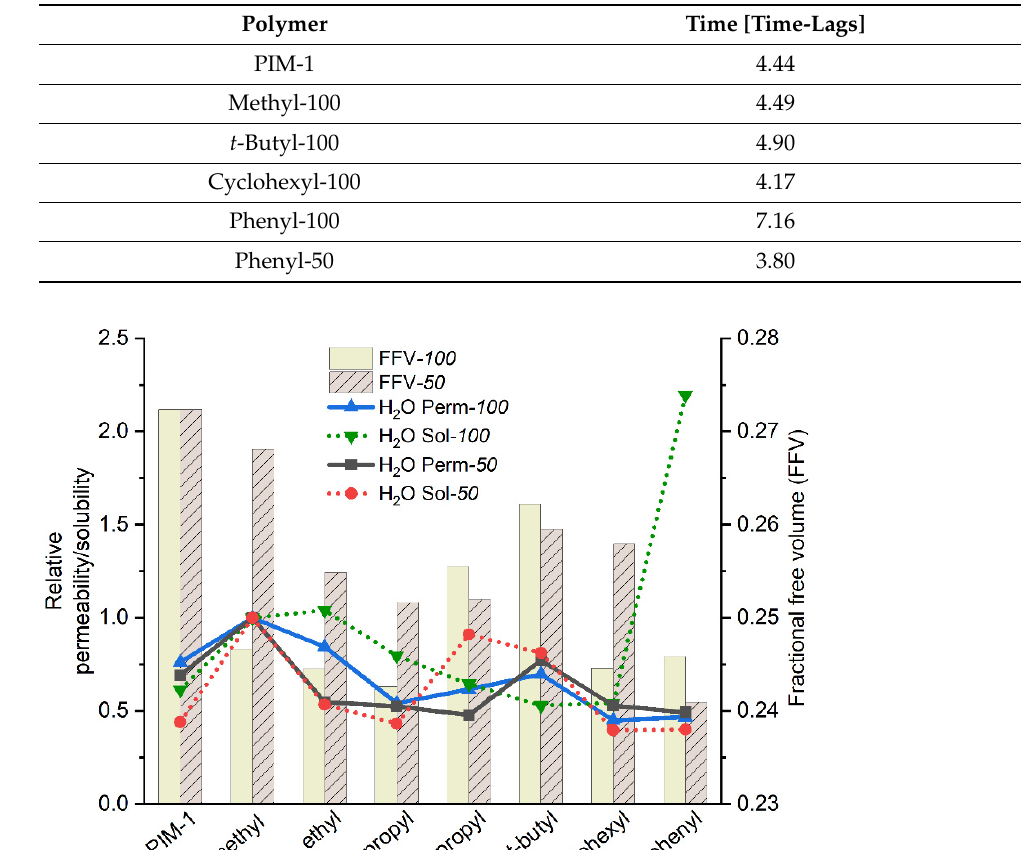
Table 2. Comparison of the moments where the time-lags of polymers reach their maximum values.